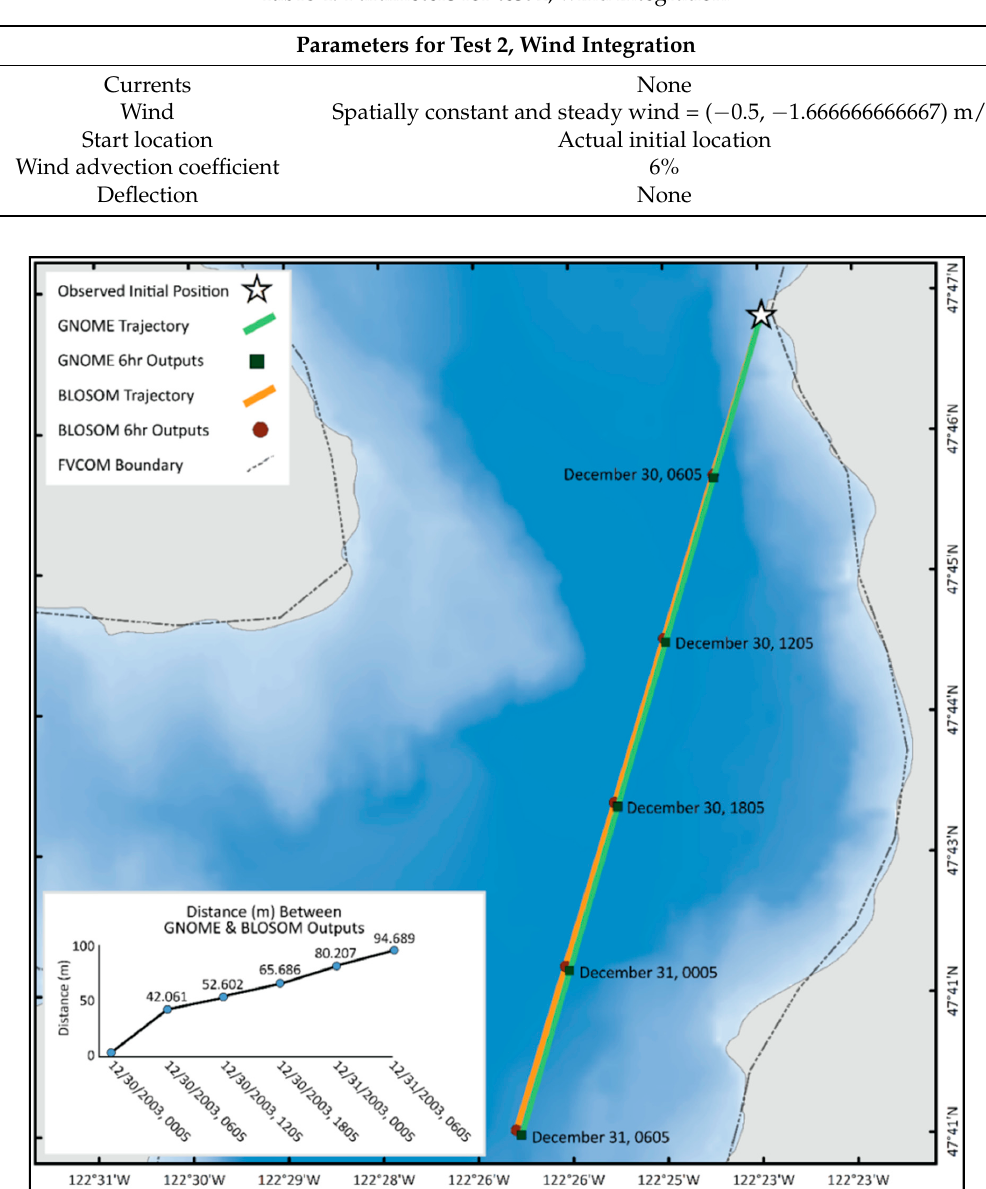
Figure 11. Comparison using constant wind, trajectories diverge with the separation between them is plotted in the bottom left inset; test 2. plotted in the bottom left inset; test